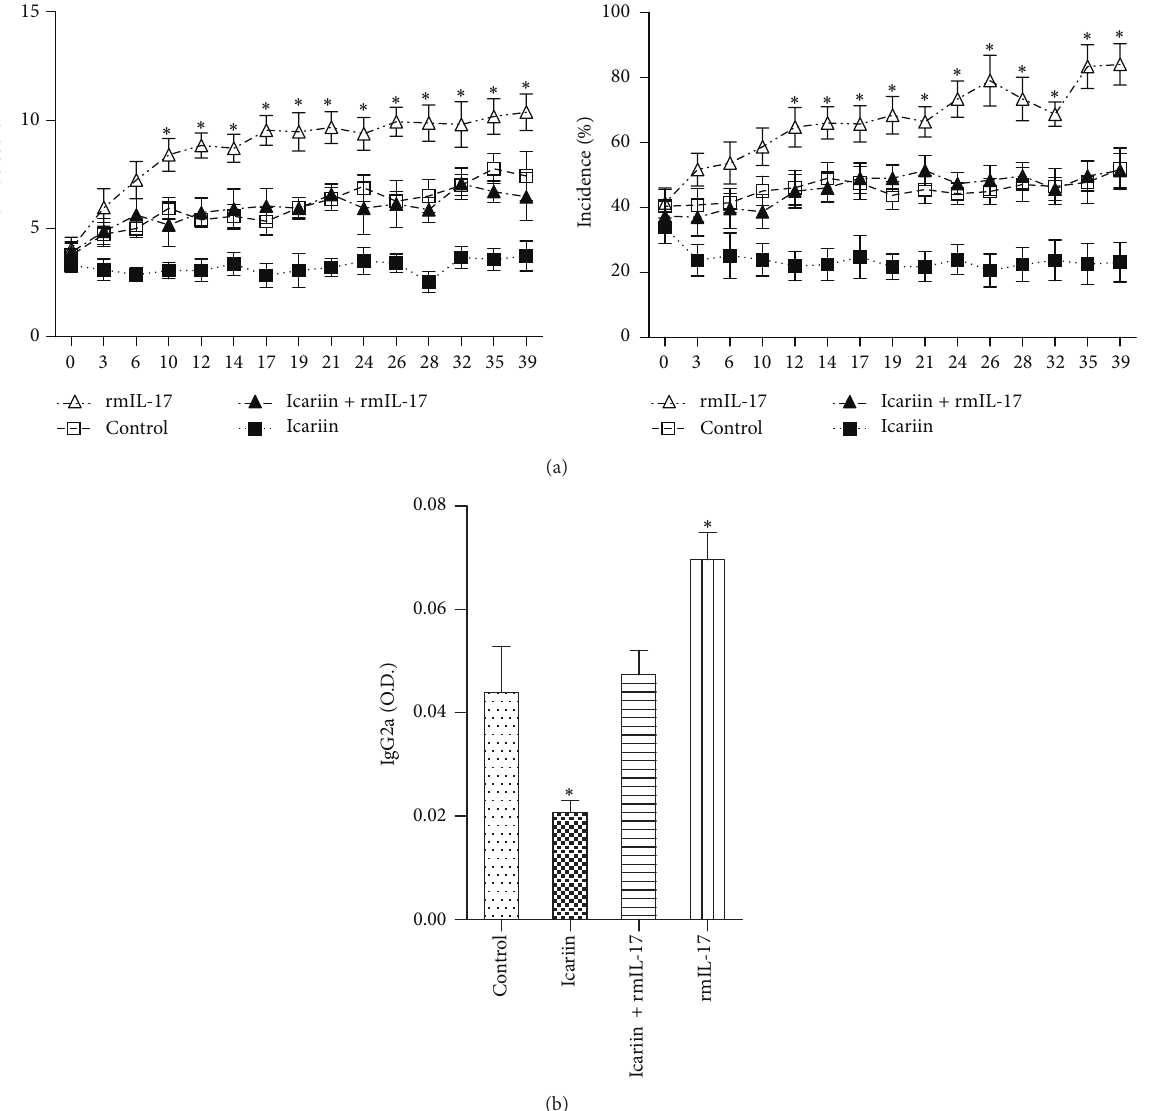
Figure 5: Icariin suppresses inflammatory arthritis partly dependent on inhibited IL-17 production, indicating arthritis score and incidence of arthritis in mice with CIA in the control, icariin, icariin + rmIL-17, and rmIL-17 groups. ∗ 𝑃 < 0.05 versus all other groups, 𝑛 = 6